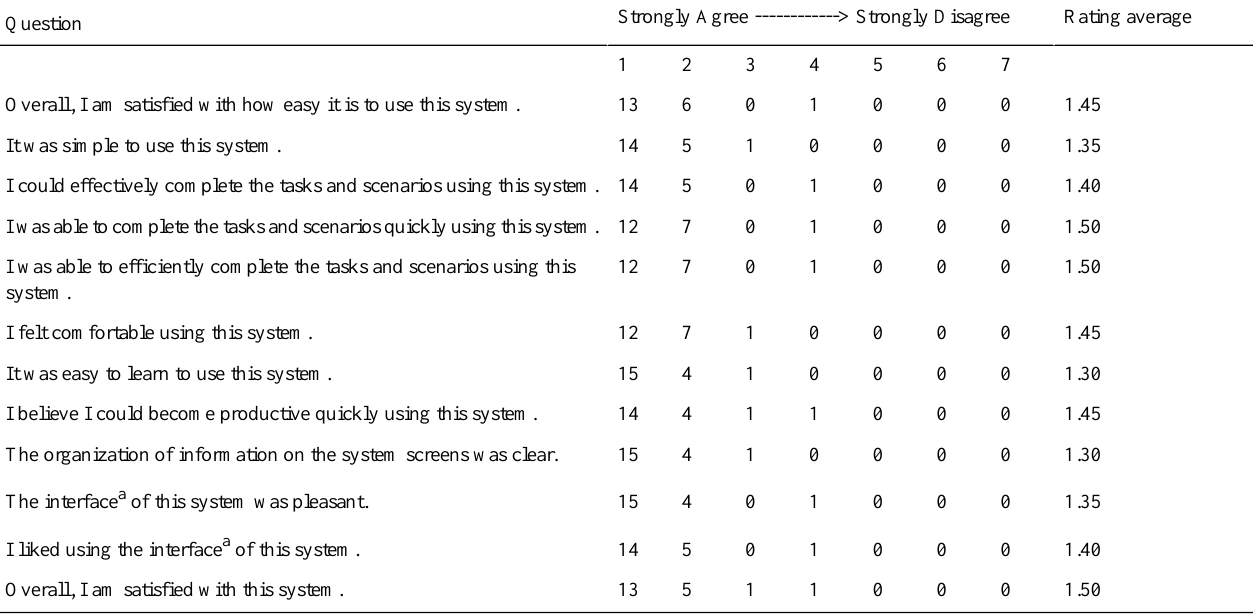
Table 4. Usability and workload of the prototype near field communication-enabled medication administration system, assessed through a modified International Business Machines Post Study System Usability